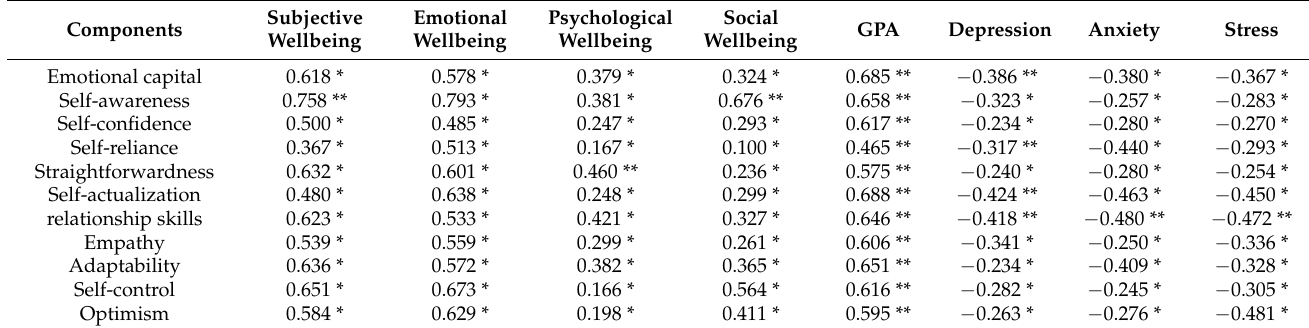
Table 7. Correlation between PECQ and subjective well-being, social well-being, psychological well-being, GPA, depression, anxiety, and stress.